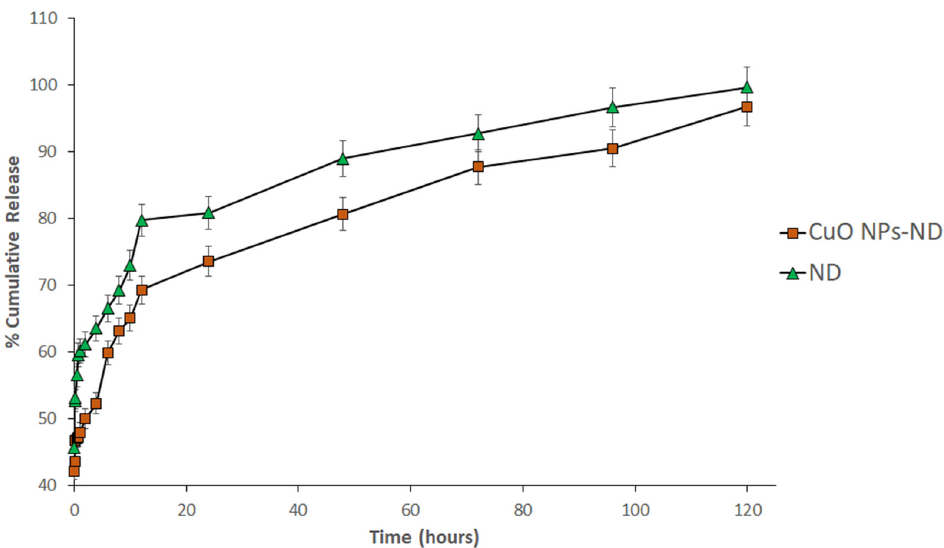
Figure 3. Cumulative release of 0.09 mM nedaplatin formulation from CuO NPs-ND and free ND. Each value shown is the average of triplicate experiments. Error bars represent ± standard deviation.